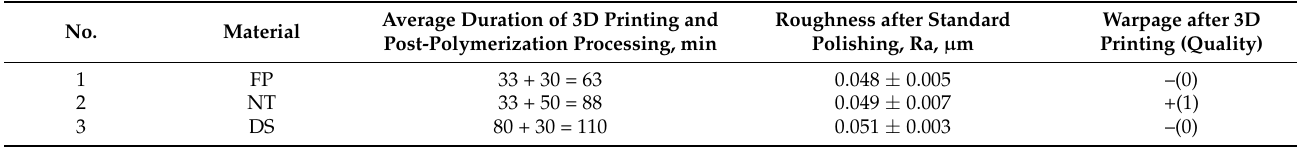
Table 7. The technological properties of 3D-printed PMMA